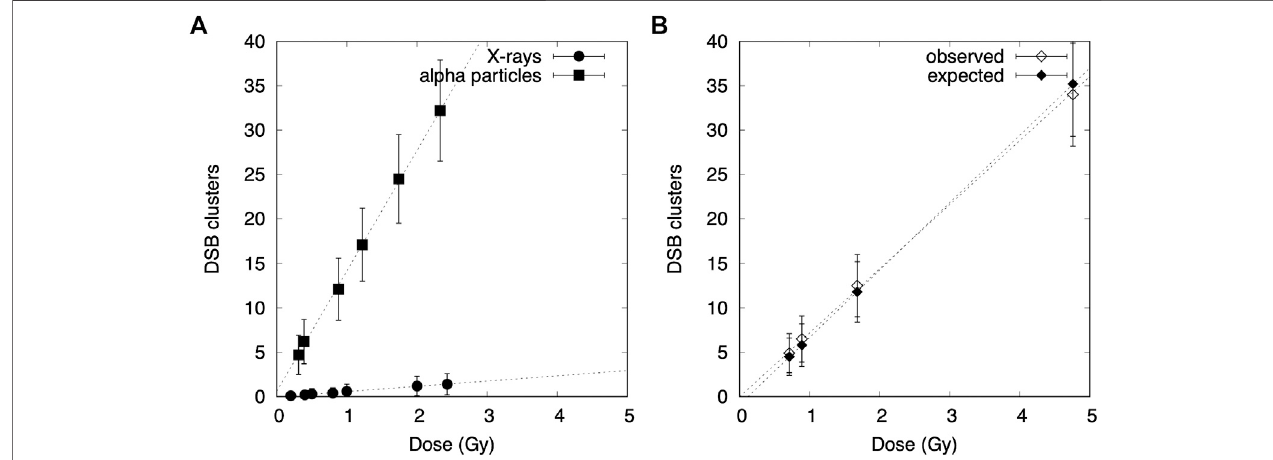
FIGURE 4 | Dose – response curves for simulated DSB clusters in lymphocytes exposed to X-rays, alpha particles, and mixed beams: (A) comparison between alpha particles and X-rays, (B) calculated values for a mixed beam simulation compared with expected values if additivity is preserved.